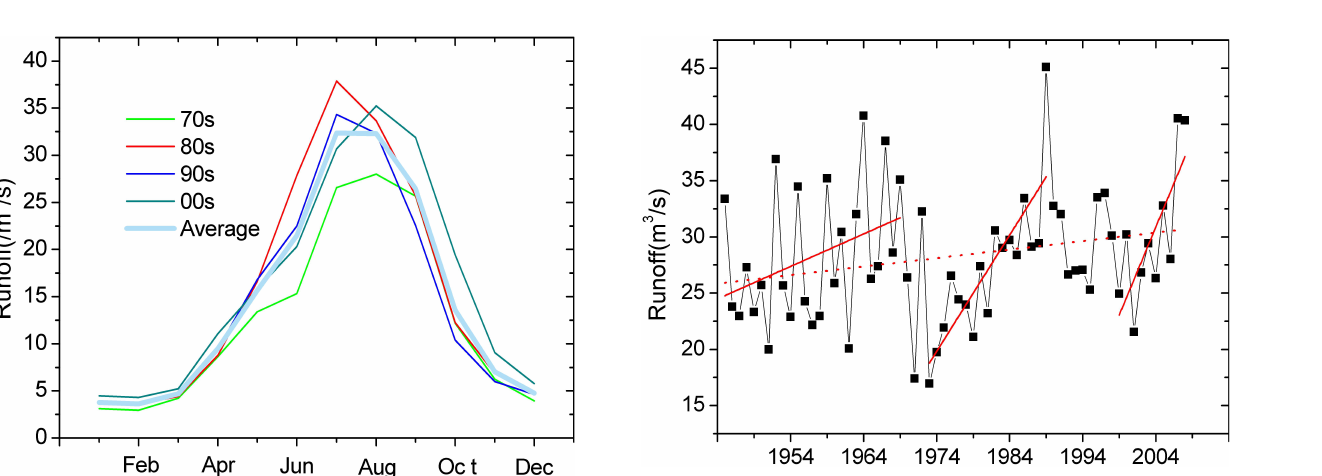
Fig. 11. Monthly spring snowmelt runoff changes of YingLuoXia station (March to